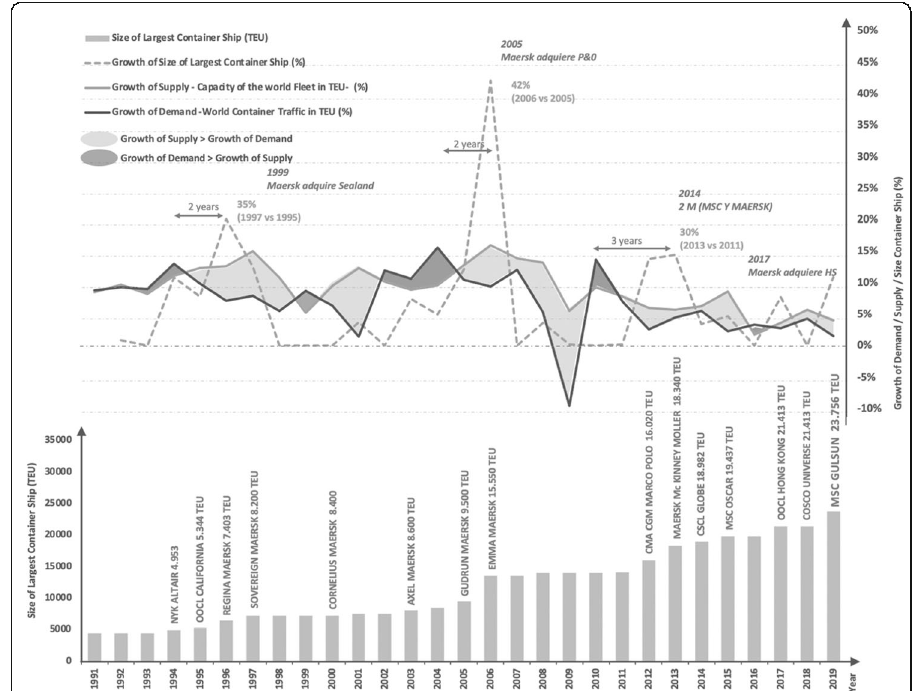
Fig. 5 Increase in container ship size about variation in fleet and trade traffic. Source: author. Notes: 1. Remarkable Mergers & Acquisitions; 2. Total fleet, on service, and idle. 3. Ship capacity is estimated. 4. In 2012, CMA-CGM Marco Polo was delivered and on service. Source: Author, based on Gomez Paz (2013);Clarkson (1998 – 2020); Alphaliner (2011, 2014, 2019, 2020); Barry, Rogliano, Sales